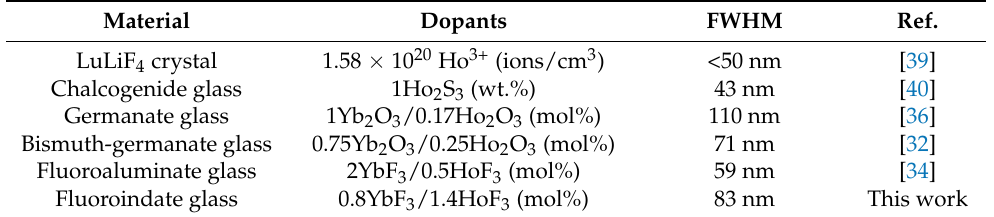
Table 2. Comparison of the FWHM of MID-IR emission band in glasses and crystals doped with Ho 3+ .